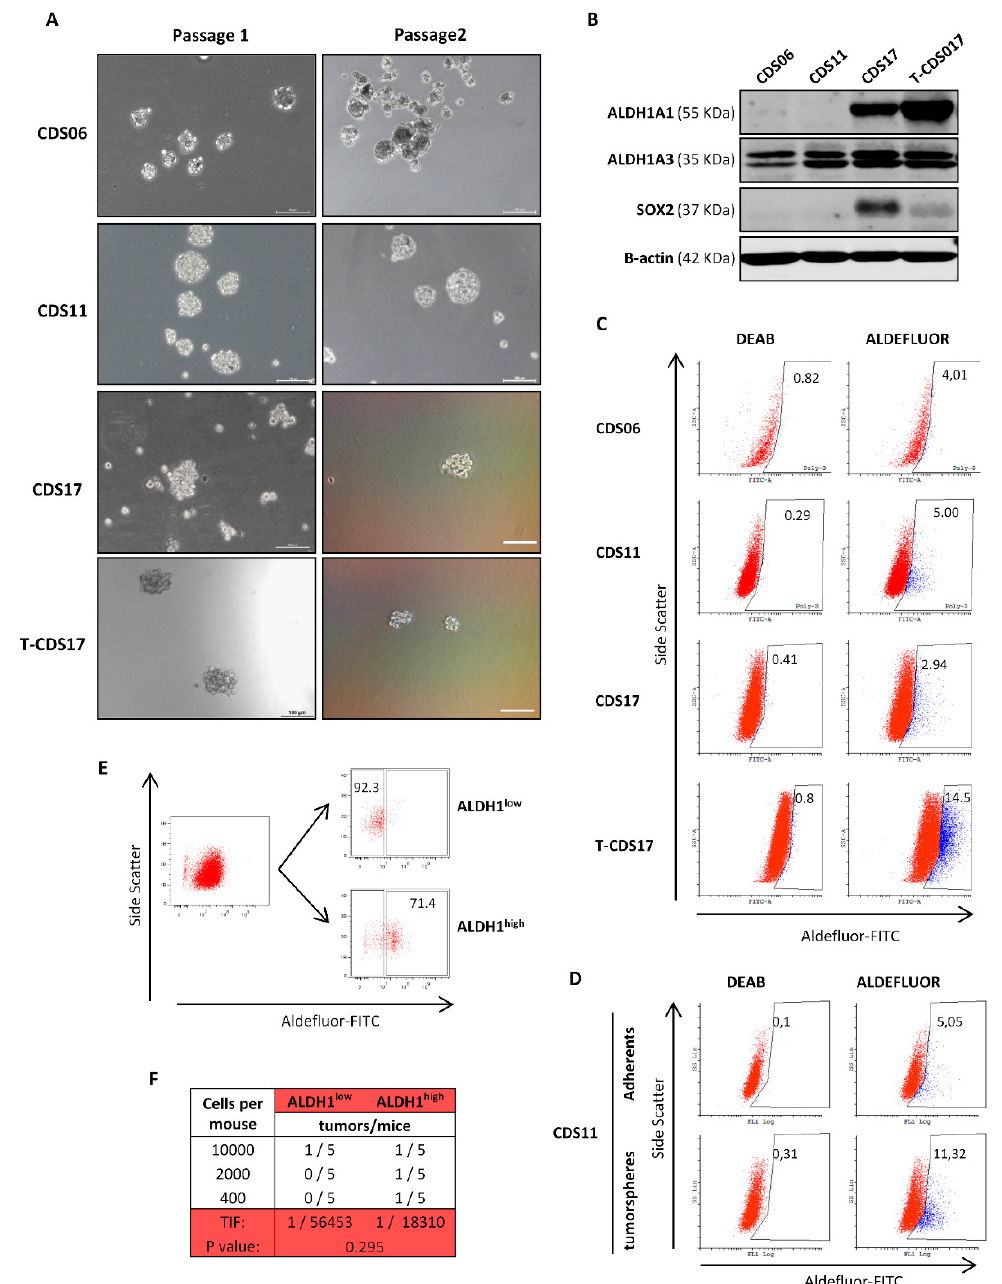
Figure 5. Characterization of cancer stem cell (CSC) subpopulations in chondrosarcoma cell lines. ( A ) Representative images of tumorspheres formed from the indicated cell lines in two successive passages. Scale bar = 100 µ m. ( B ) Protein levels of Aldehyde Dehydrogenase 1 Family Member-A1 (ALDH1A1), -A3 (ALDH1A3), and Sex Determining Region Y-Box 2 (SOX2) in the indicated cell lines. β -actin levels were used as a loading control. ( C ) Aldefluor assay showing the activity of ALDH1 in the indicated cell lines. ALDH1 activity was blocked with the specific inhibitor N,N-diethylaminobenzaldehyde (DEAB) to establish the basal levels. ( D ) Comparison of Aldefluor activity in adherent and tumorsphere cultures of CDS11 cells. ( E ) Flow cytometry cell sorting of Aldefluor high (ALDH1 high ) and low (ALDH1 low ) populations in T-CDS17 cells. ( F ) Limiting dilution assay to evaluate tumor initiation frequency (TIF) of ALDH1 high and ALDH1 low T-CDS17 cells. The number of mice that grew tumors after 4 months and the total number of inoculated mice for each condition is indicated. TIF was calculated using ELDA software.